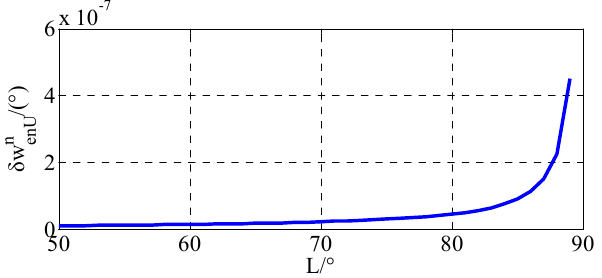
 and L . Figure 7. Relationship between δω n and L enU enU